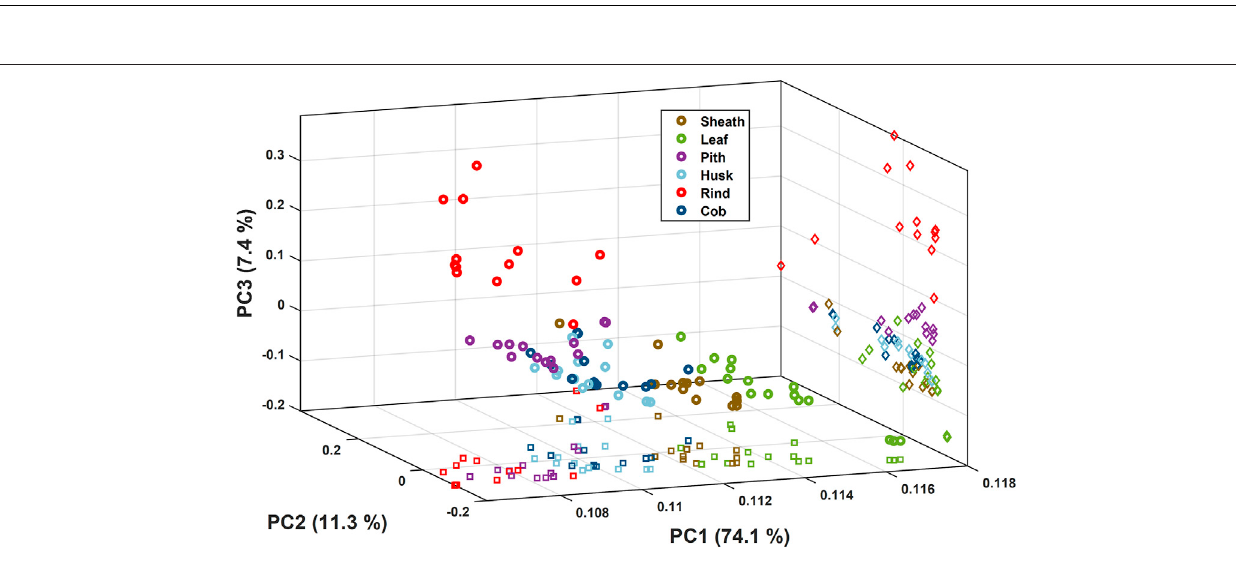
Frontiers in Energy Research |